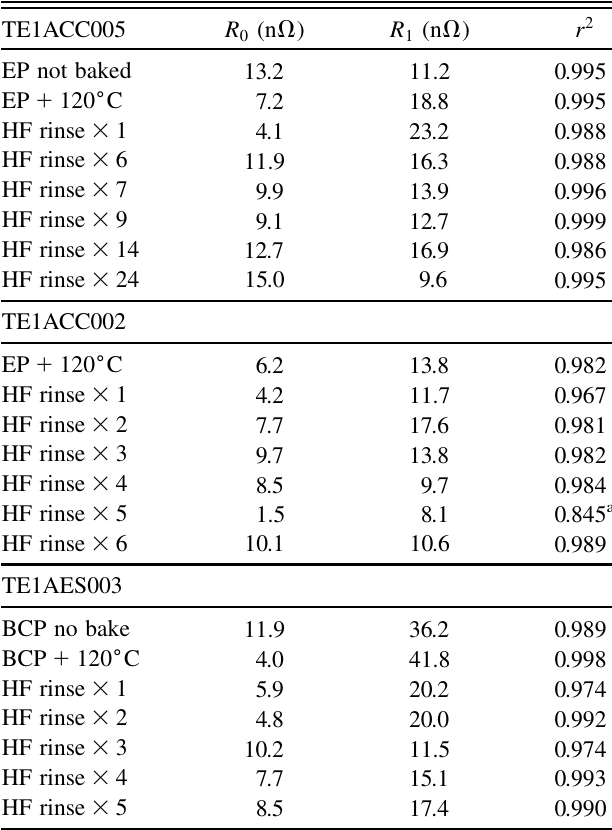
TABLE IV. ParametersforthefitsbasedonEq.(2)ofthemedium field Q slopeinthebulkelectropolished(EP)cavity(TE1ACC005), bulk EP þ tumbling þ light EP cavity (TE1ACC002), and a buf- fered chemically polished (BCP) cavity (TE1AES003).